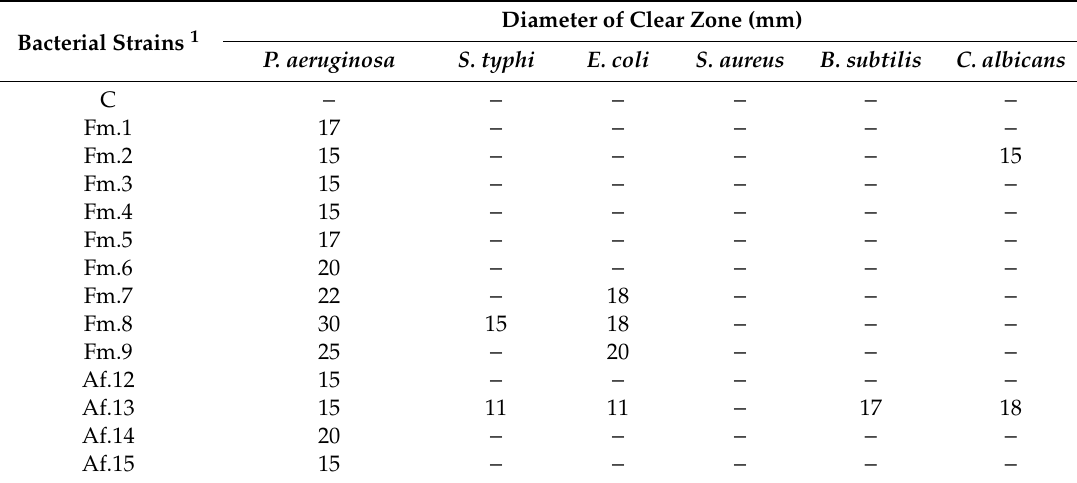
1 C: controls without bacterial inoculation. Identity of the bacterial isolates is available in Table